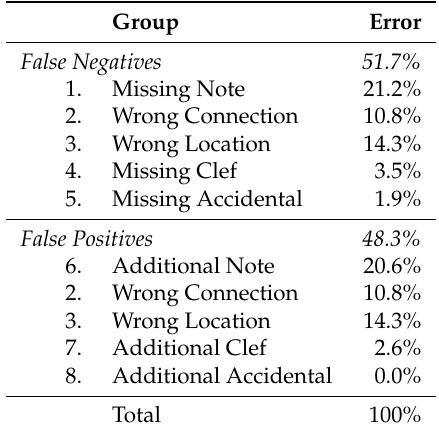
Table 9. Error analysis: The relative amount of errors of the output sequence is categorised.